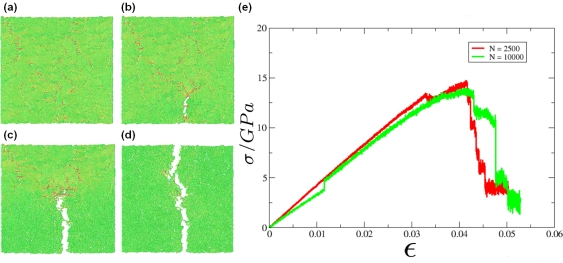
Crack initiation and propagation in the virtual macroscopic material sample upon uni-axial tensile load using N = 104 particles. The color code is: Force-free bonds (green); Bonds under tensile load (red). (a) Initiation of local tensions. (b) Initiation of a crack tip with local tensions concentrated around this crack tip. (c) Crack propagation including crack instability. (d) Failure. (e) Averaged stress-strain (σ-ε) relation. For N = 2500 (green curve) 10 different systems were averaged, and for N = 10000 (red curve) the stress-strain relations of 5 different initial particle configurations obtained in uni-axial load simulations were averaged.